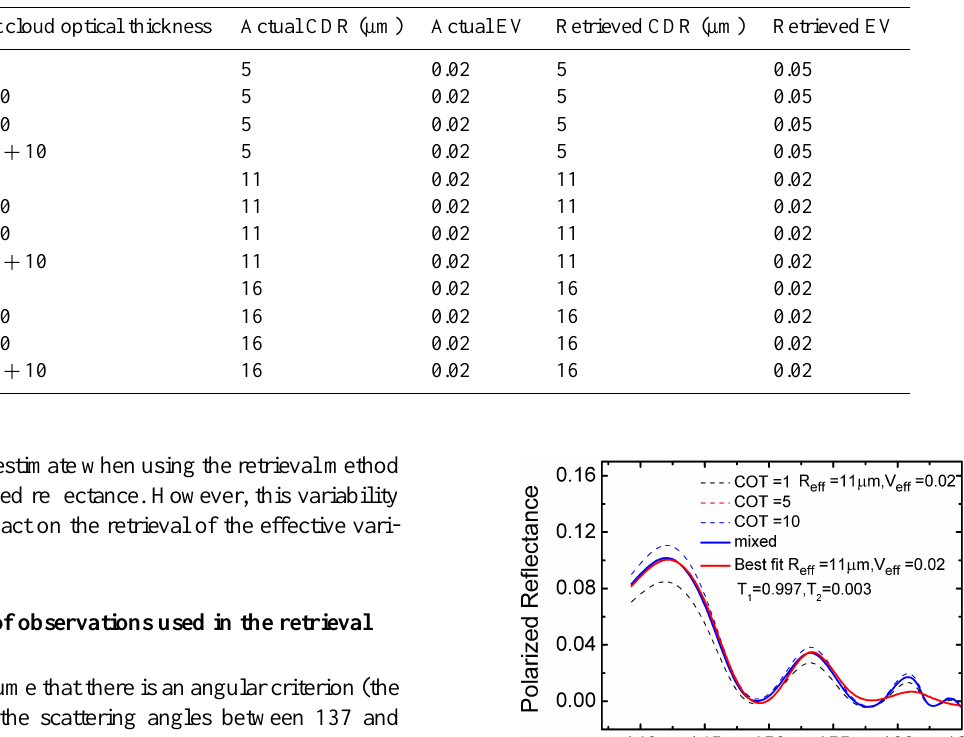
Table 3. Retrievals from a heterogeneous cloud field with variable COT using POLDER-like polarized reflectances in the 137–165 ◦ range. In all cases, the EV in the sub-grid-scale cloud was assumed to be 0.02, and the CDR values included 5, 11, and 16µm. The “ + ” indicates the equal share of the COTs in the cloud fields.